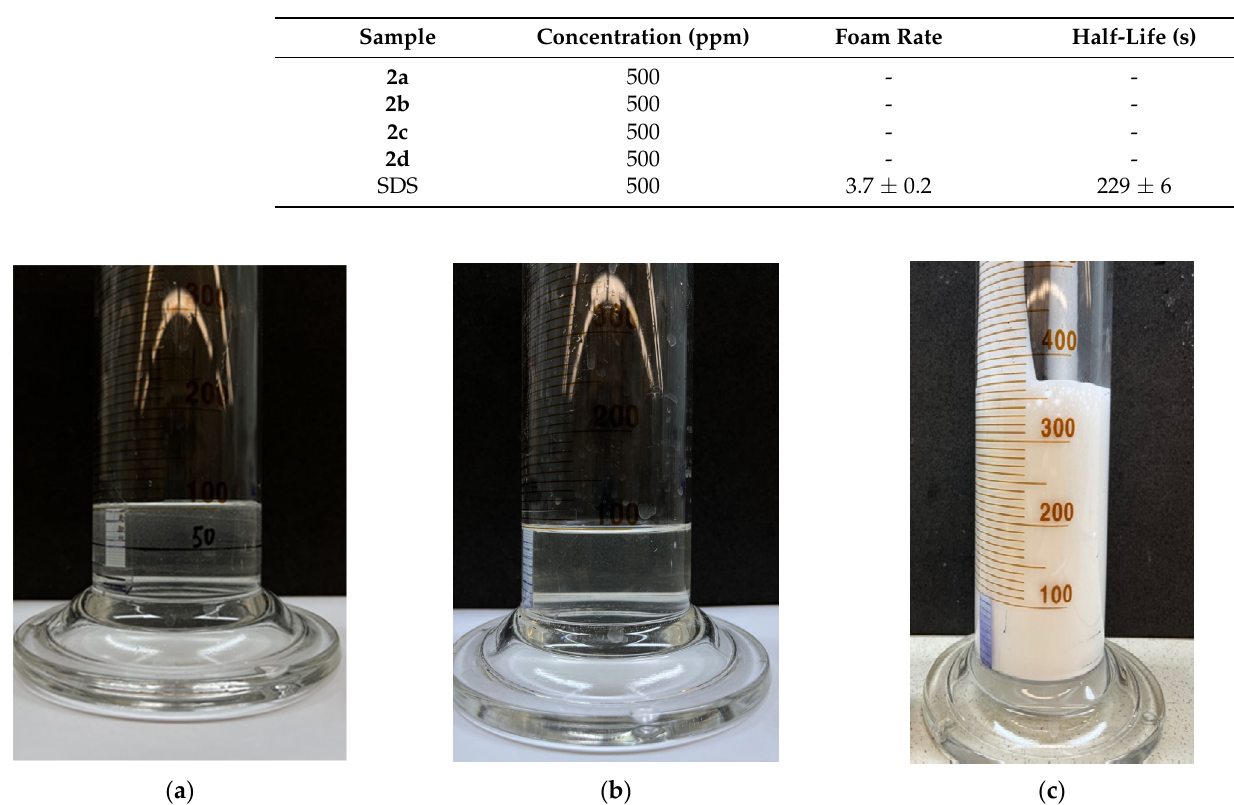
Table 2. Foam formation of synthesized promotors and SDS.